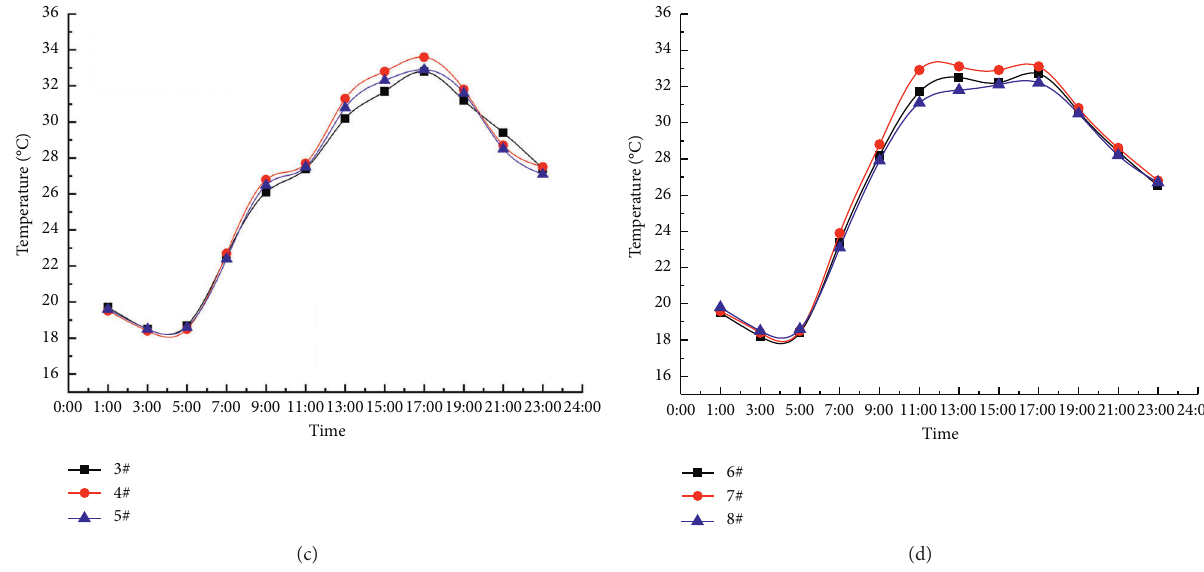
Figure 7: Curves of measuring points and ambient temperature with time on June 11, 2021. (a) Ambient temperature, measuring point #1 and measuring point #2. (b) Ambient temperature, measuring point #9 and measuring point #10. (c) Measuring points #3, # 4, and #5. (d) Measuring points #6, #7, and #8.